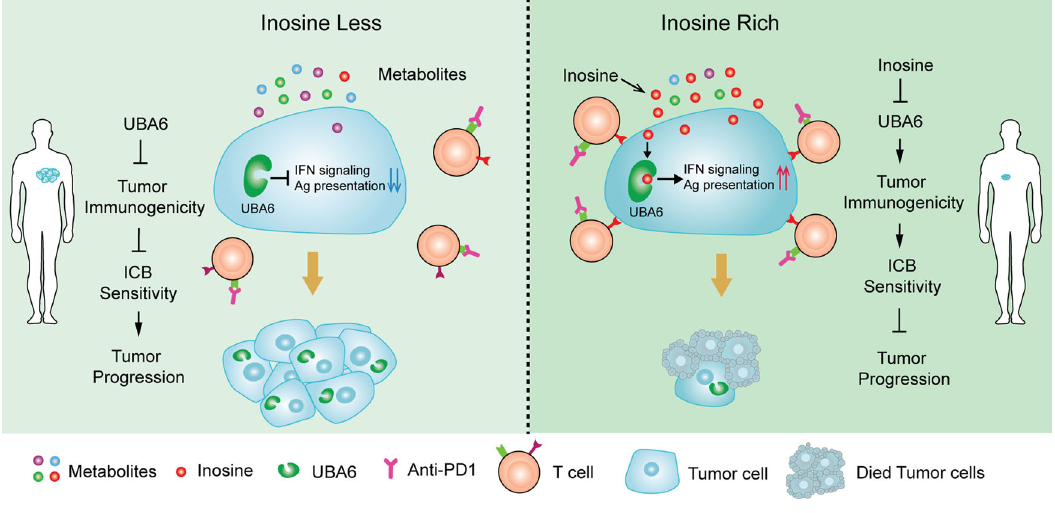
Fig. 7 | A summary model linking inosine and immunotherapy responses. The metabolic imbalance, especially inosine, is associated with immunotherapy responses in mice and humans. Inosine overcomes tumour-intrinsic resistance